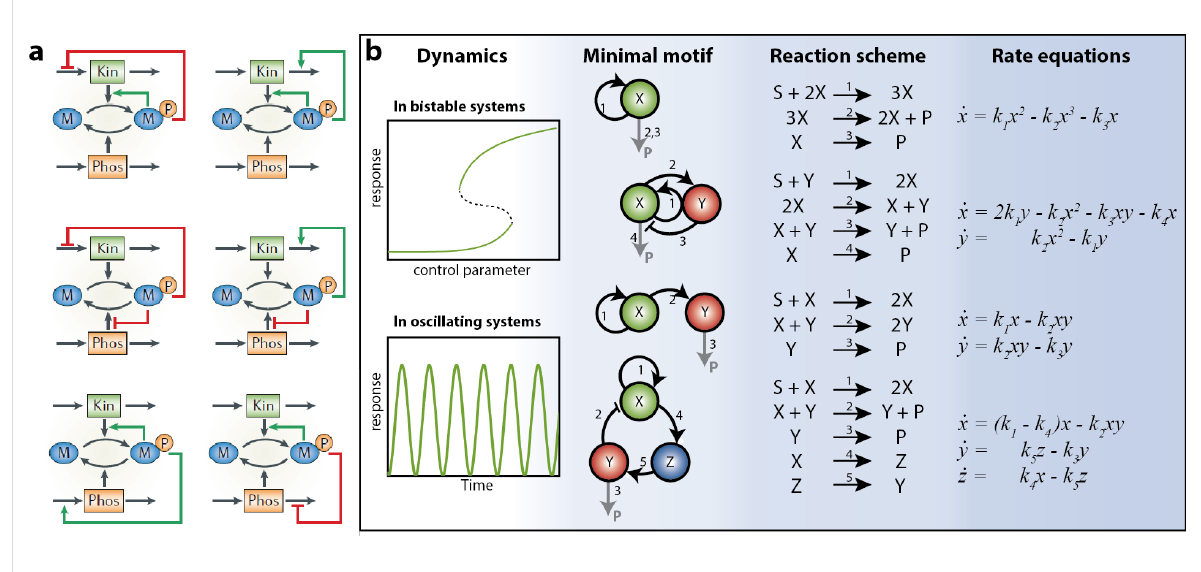
Figure 1: Network motifs. (a) Examples of network motifs composed from different feedback loops. Each design can turn a universal signaling cycle into a bistable switch and relaxation oscillator. Adapted with permission from [24], copyright 2006 Nature Publishing Group. (b) Minimal network motifs that describe the dynamics of minimal bistable or oscillatory systems using mass-action kinetics